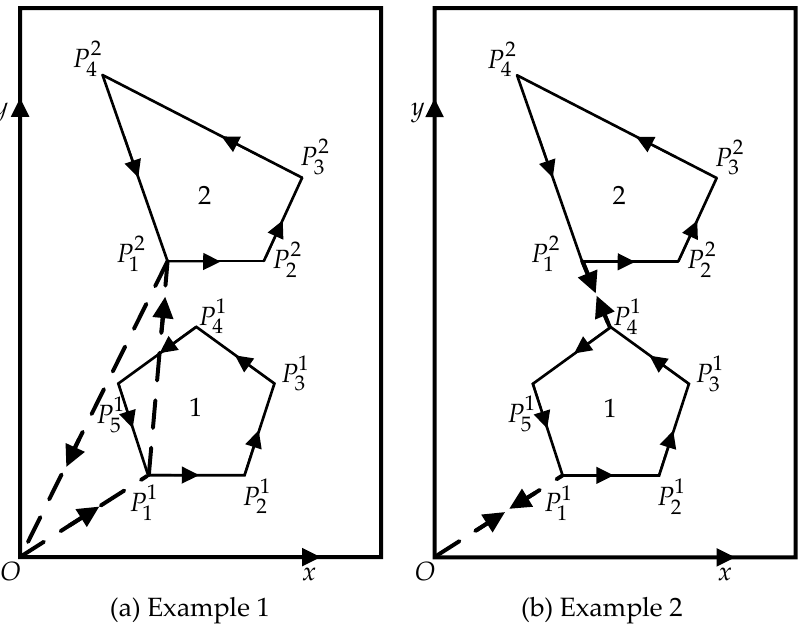
Figure 5. Example comparison of two cutting paths.